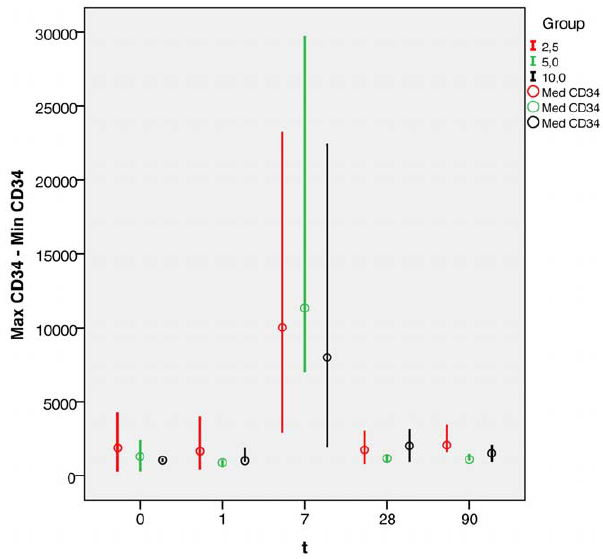
Figure 2. Absolute CD34 + cell count/ m l over time as median with minimum and maximum over time in the three different